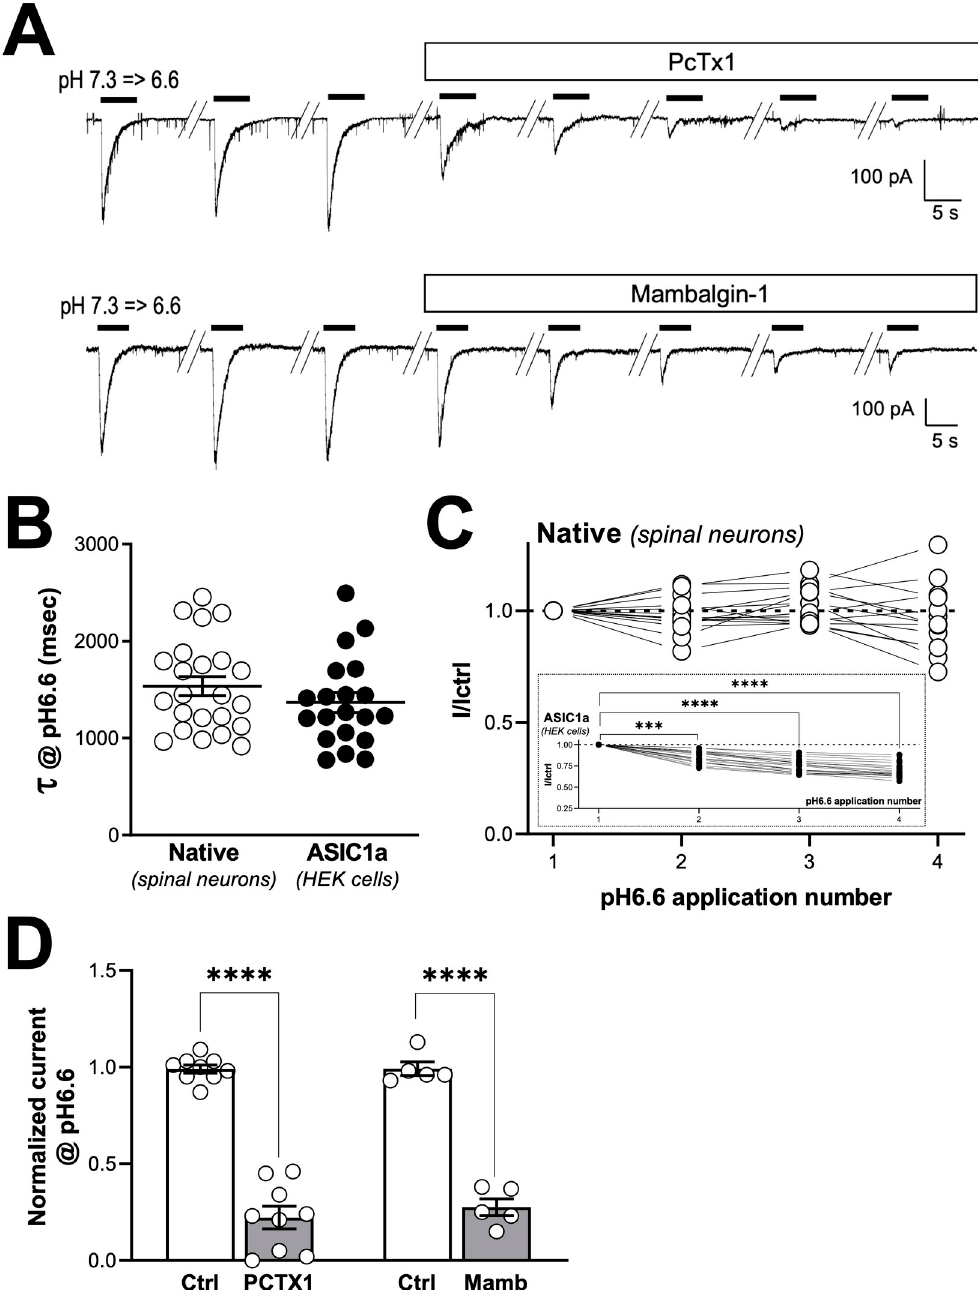
Fig 2. Characterization of a native ASIC1a-type current in deep projection neurons from laminae V. A , Typical voltage- clamp recordings of deep projection neurons (laminae V) obtained from spinal cord slices following extracellular acidifications from pH7.3 to pH6.6. Extracellular applications of the ASIC1a inhibitory peptides PcTx1 (30nM) or mambalgin-1 (1 μ M) both decrease the amplitude of native pH6.6-induced currents. B , Inactivation kinetics of native pH6.6-induced currents recorded in spinal neurons (native) are compared to those of ASIC1a homomeric currents form HEK293 transfected cells (form pH7.4 to 6.6). Inactivation rates ( τ ) were obtained by fitting current inactivation decays with a mono-exponential (n = 23 and 20 for spinal neurons and ASIC1a-HEK293 cells, respectively, p = 0.2399, unpaired t - test). C , Peak amplitude of the native ASIC current recorded in neurons following four consecutive pH6.6 extracellular acidifications (from 7.3 to 6.6 every 60s). Amplitudes are normalized to the first pH6.6-evoked current (n = 14, no significant tachyphylaxis process with p = 0.1882, one-way ANOVA test followed by a Dunnet’s post hoc test). Inset shows the same experiment performed on ASIC1a homomeric current recorded in HEK293 cells (from 7.4 to 6.6 every 60s, n =